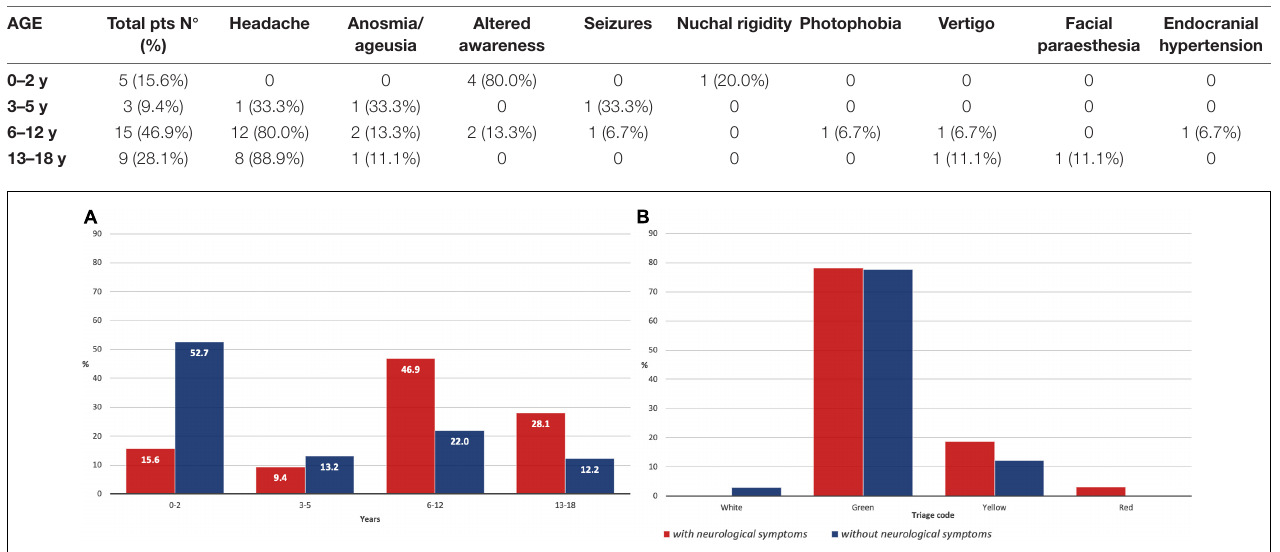
FIGURE 3 | (A) Patients with and without neurological symptoms stratified by age range; (B) Patients with and without neurological symptoms stratified for priority triage code at the Emergency Department